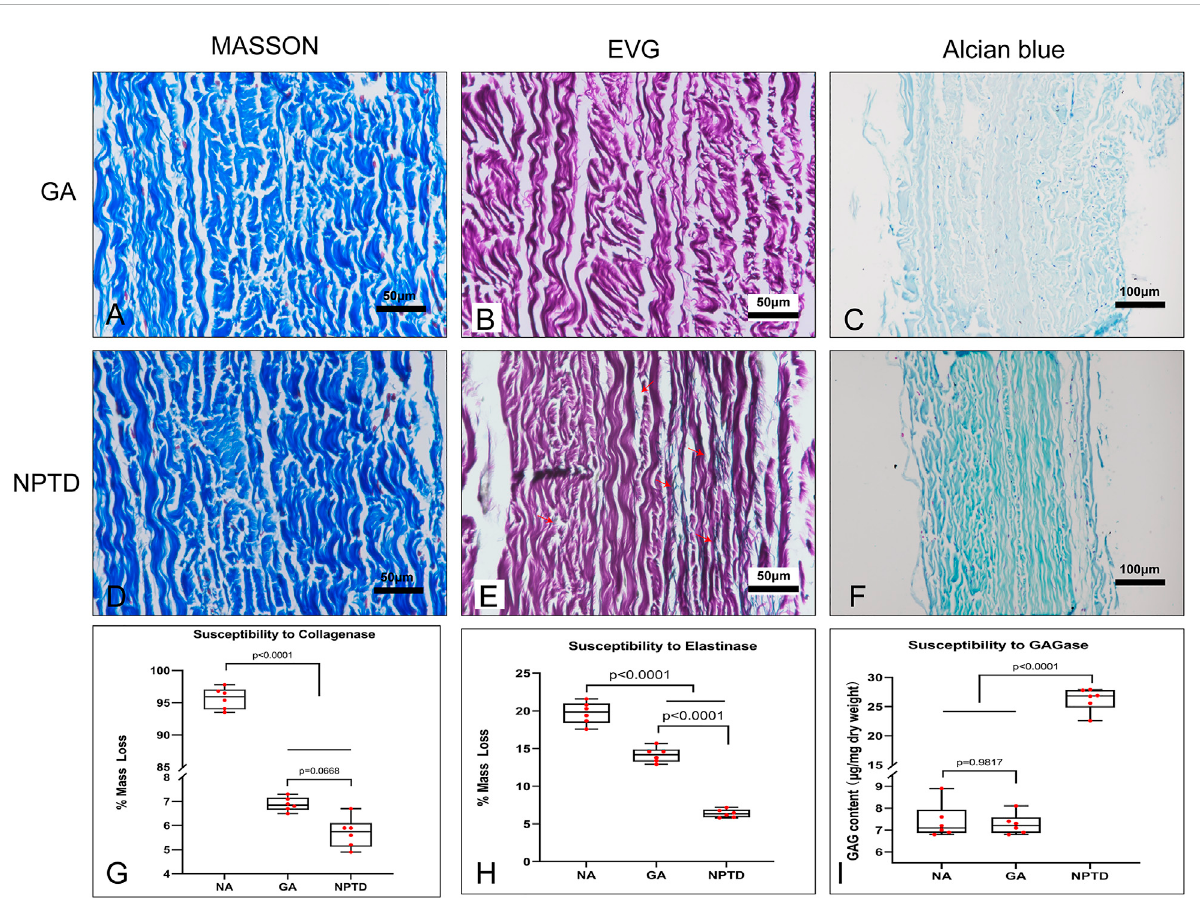
FIGURE 6 Histological features and quantitative analysis after enzymatic hydrolysis of cross-linked pericardium. The images of Masson ’ s trichrome staining after collagenase hydrolysis (A,D) . The images of elastic Van-Gieson staining after elastinase hydrolysis (B,E) , Red arrows show preserved elastic fi bers in the NPTD group. The images of Alcian blue staining after hyaluronidase hydrolysis (C,F) . The quantitative analysis of mass loss and residual GAGs content in each group after enzymatic hydrolysis (G – I) . Statistical analysis was performed by one-way analysis of variance